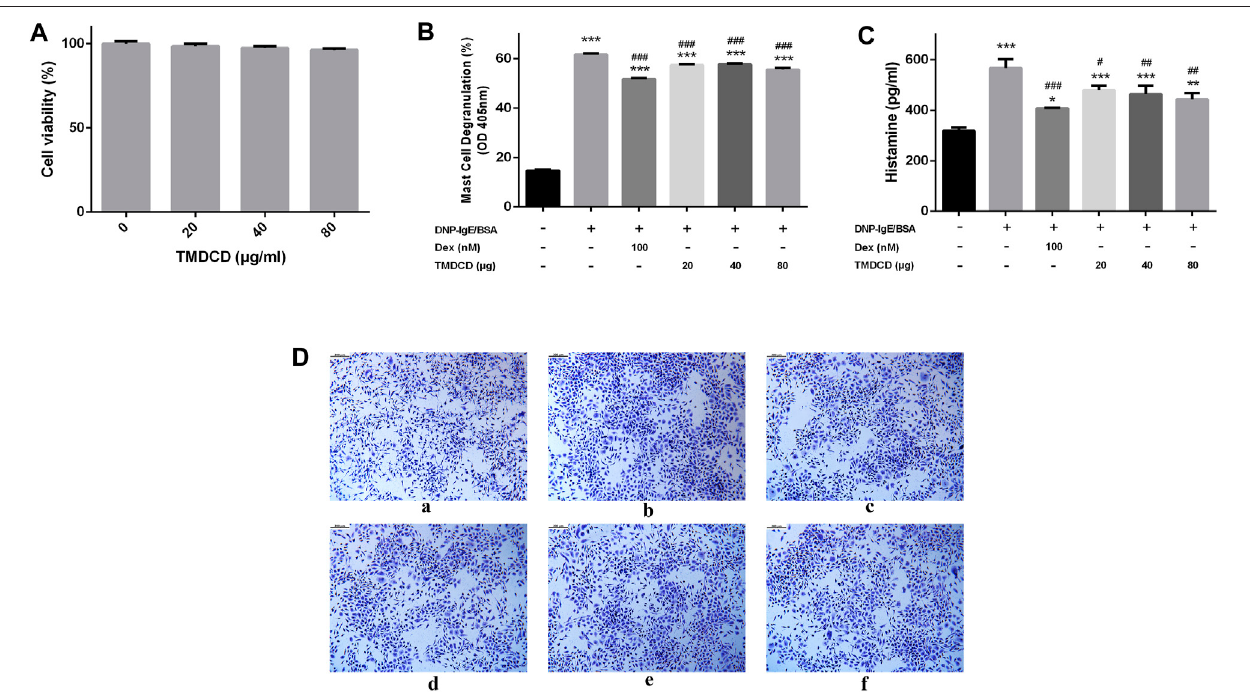
FIGURE 8 | Effect of TMDCD on degranulation of mast cells. (A) Effect of TMDCD on the viability of RBL-2H3 cells. (B) Effect of TMDCD on the release of β -hexosaminidase. The results were expressed as Mean ± SEM. (C) Effect of TMDCD on histamine release. (D) Effect of TMDCD on morphology of RBL-2H3 cells sensitized by DNP-IgE/BSA. a. Blank group; b. Model group; c. Dexamethasone group; d. TMDCD 20 μ g/ml group; e. TMDCD 40 μ g/ml group; f. TMDCD 80 μ g/ml group (toluidine bluestaining,originalmagni fi cation × 100).Comparedwiththecontrolgroup, *** p < 0.001,compared withthemodel group,# p < 0.05, ## p < 0.01 and ### p <